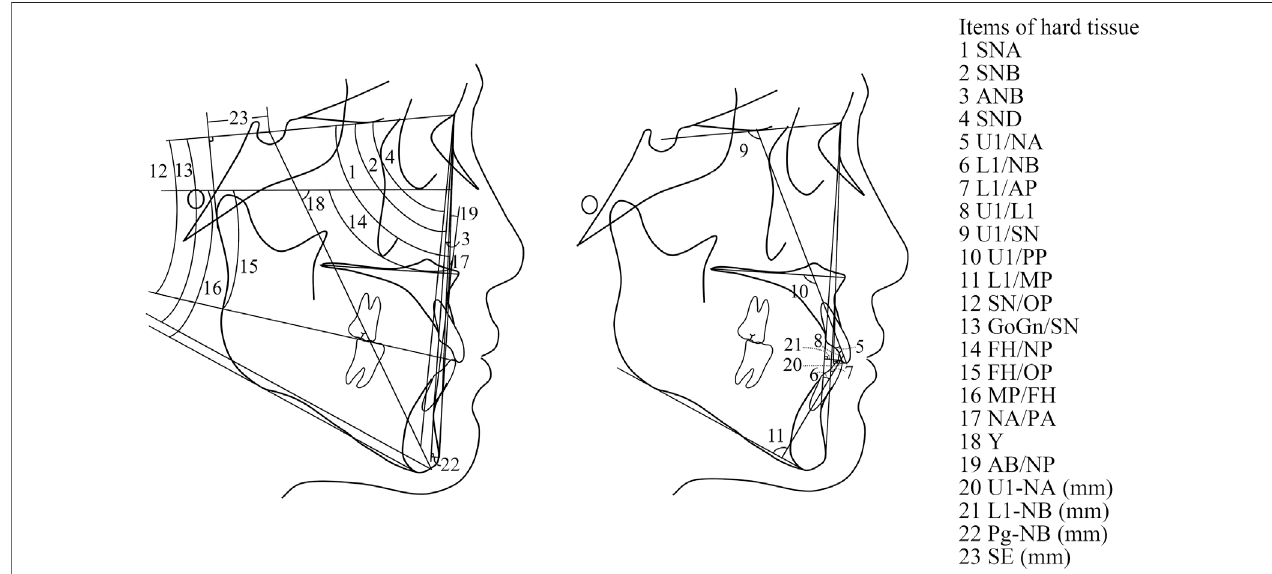
FIGURE 2 | Cephalometric measurements of hard tissue.